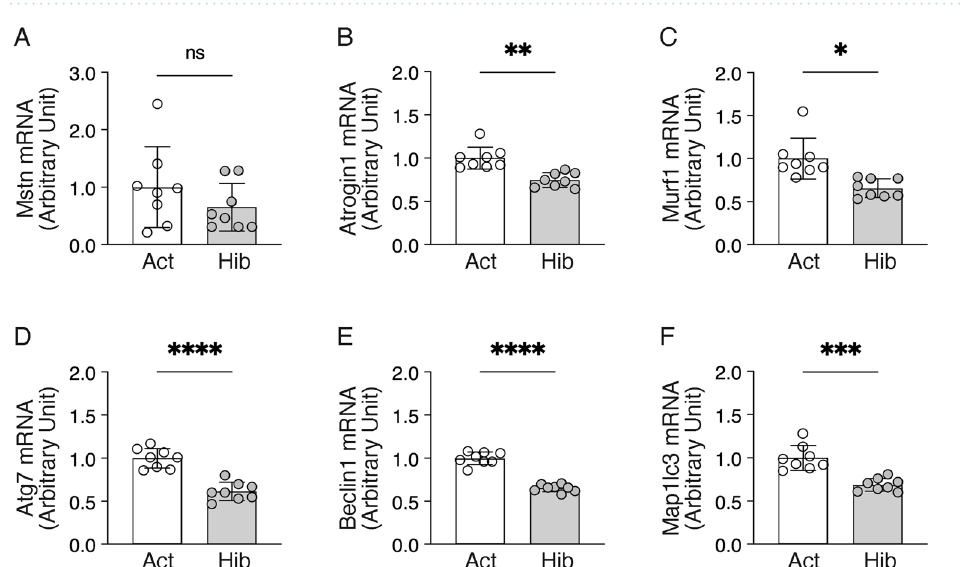
Figure 4. Alterations in the regulatory systems for energy metabolism in bear skeletal muscles during hibernation. Typical western blotting images of signaling molecules involved in the regulatory systems for energy metabolism and their quantification results are presented. ( A – C ) phosphorylated (Thr172) and total expression of AMPKα. ( D – G ) phosphorylated (Ser939 and Ser1387) and total expression of TSC2. n = 8 in each group. All results are expressed as mean ± standard deviation (SD). Significant differences: *p < 0.05, ****p < 0.0001 between active versus hibernation period.